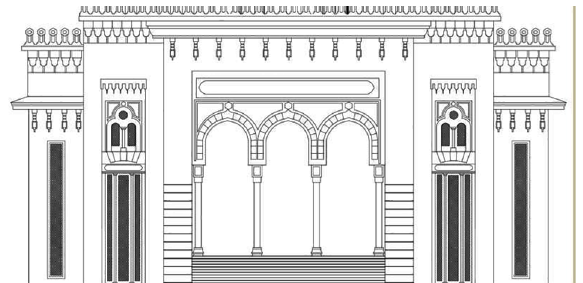
Figure 14. 2D drawing of El-Nasr Mosque façade depending on resulted image processing